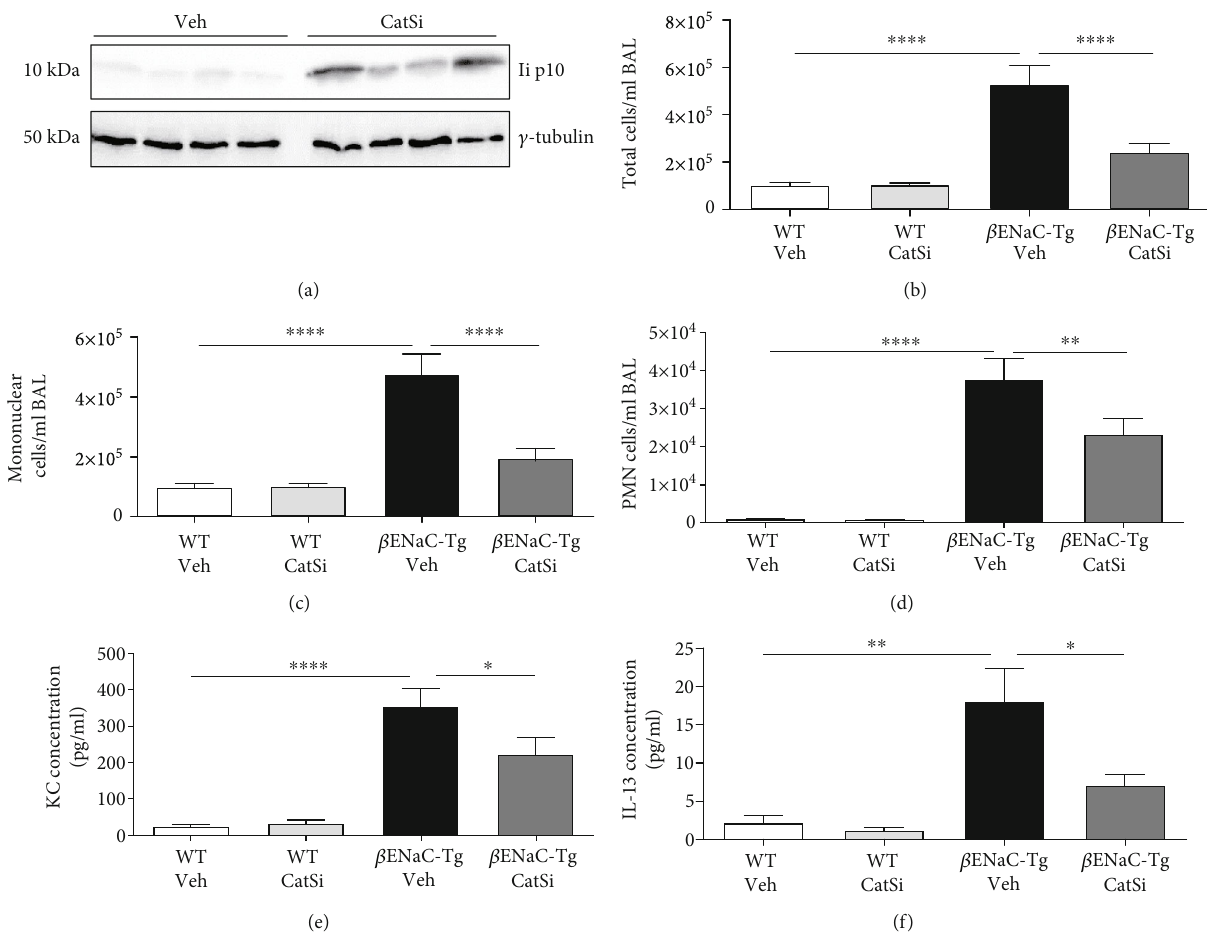
Figure 5: Pharmacological targeting of cathepsin S reduces airway in fl ammation in adult β ENaC-Tg mice. Four-week-old WT and β ENaC- Tg mice were treated daily with cathepsin S inhibitor VBY-999 (CatSi; 100 mg/kg) or dextrose vehicle control (veh) for 14 days. (a) Inhibition of cathepsin S in β ENaC-Tg mice alters invariant chain (Ii) processing and results in the accumulation of the 10 kDa intermediate (p10), which was detected in lung lysate by Western blot ( n = 4 per group). BAL fl uid (b) total cell, (c) mononuclear, and (d) polymorphonuclear (PMN) cell counts were quanti fi ed ( n = 8 ‐ 20 mice per group). BAL fl uid levels of (e) KC and (f) IL-13 were quanti fi ed by ELISA ( n = 6 ‐ 11 mice per group). ∗∗ P < 0 : 01 ; ∗∗∗∗ P < 0 : 0001 (one-way ANOVA with Tukey ’ s multiple comparisons